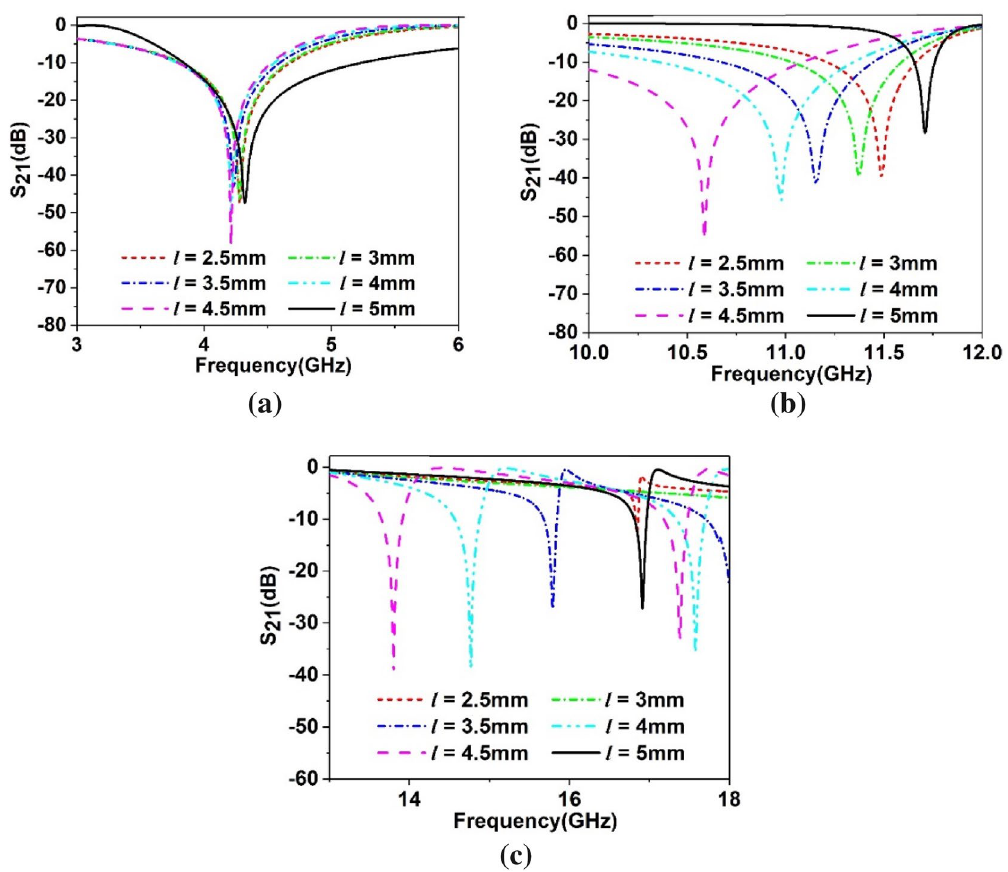
Figure 7. Transmission coefficient (S 21 ) for variation of tuning stub length, l ( a ) 3 GHz –6 GHz ( b ) 10 GHz – 12 GHz ( c ) 13 GHz – 18 GHz.